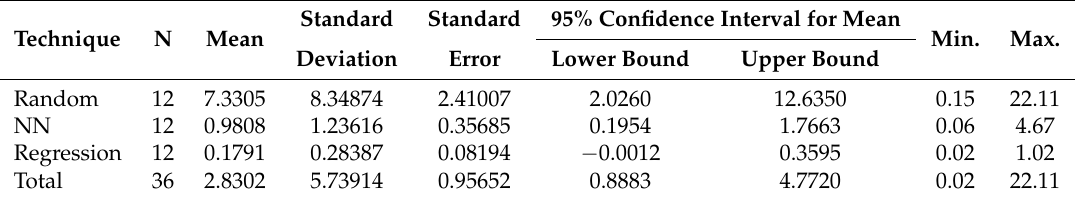
Table 14. Descriptive analysis of Random, NN and Regression technique with respect to final solution.